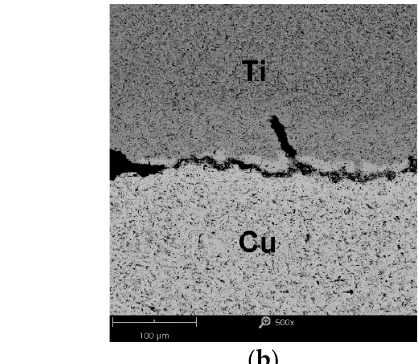
Figure 13. The contact zone of titanium and copper in the bimetal after annealing: ( a ) at T = 600 °C and t = 90 min, ( b ) at T = 800 °C and t = 60 min.